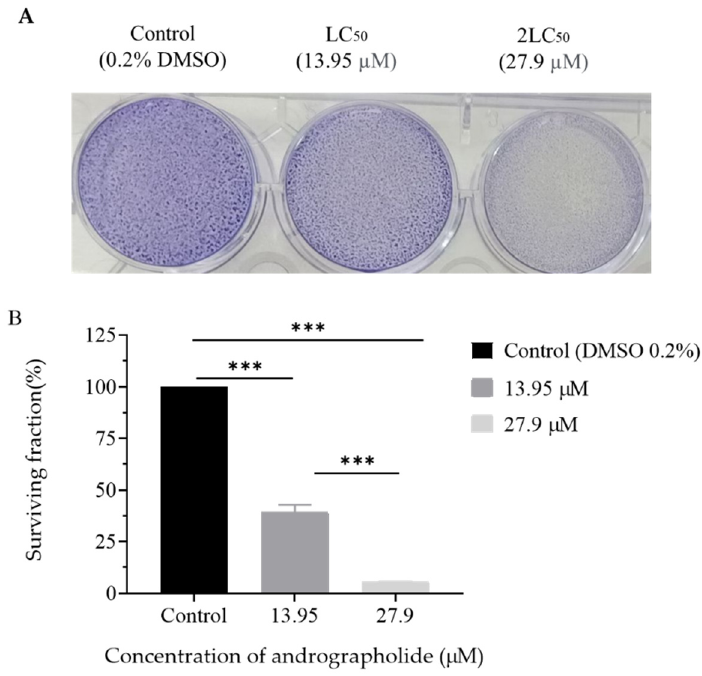
Figure 3. The effect of andrographolide in reducing colony formation of DBTRG-05MG cell lines. ( A ) Colony formation of DBTRG-05MG cells treated with 13.95 µM andrographolide and without andrographolide as the control. ( B ) The percentage of surviving fraction of DBTRG-05MG cell lines when treated with 13.95 µM and 27.9 µM of andrographolide compared with a control group. The comparison between each treatment with control was made using one-way ANOVA with Tukey's test to detect any significant differences (* p < 0.1; ** p < 0.01; *** p > 0.001; ns not significant).